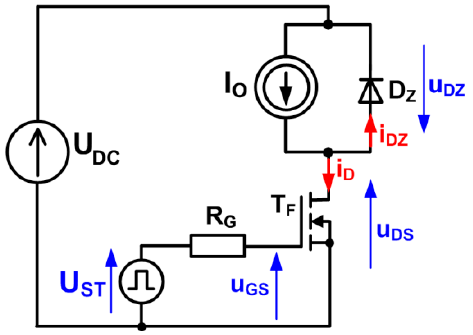
Figure 6. Basic switching cell.